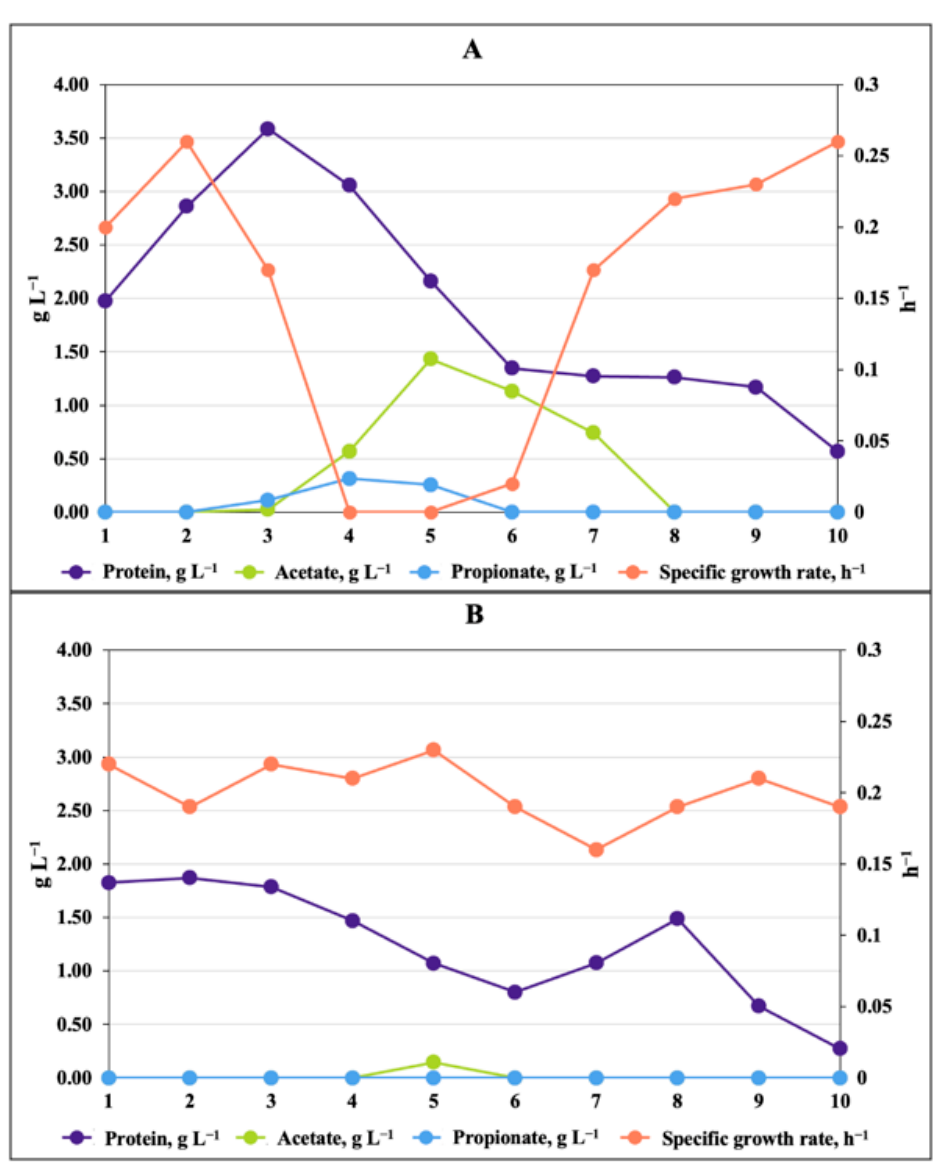
Figure 7. The composition and growth-inhibitory effect of fractions obtained by size-exclusion chromatography of lyophilized and concentrated Zm4 culture supernatant: ( A ) aerobically grown culture; ( B ) anaerobically grown culture. The specific growth rate of E. coli culture was assayed after addition of 100 µ L of the respective fraction material per 200 µ L of total working volume in a microplate well. Representative results of one experiment in a series are